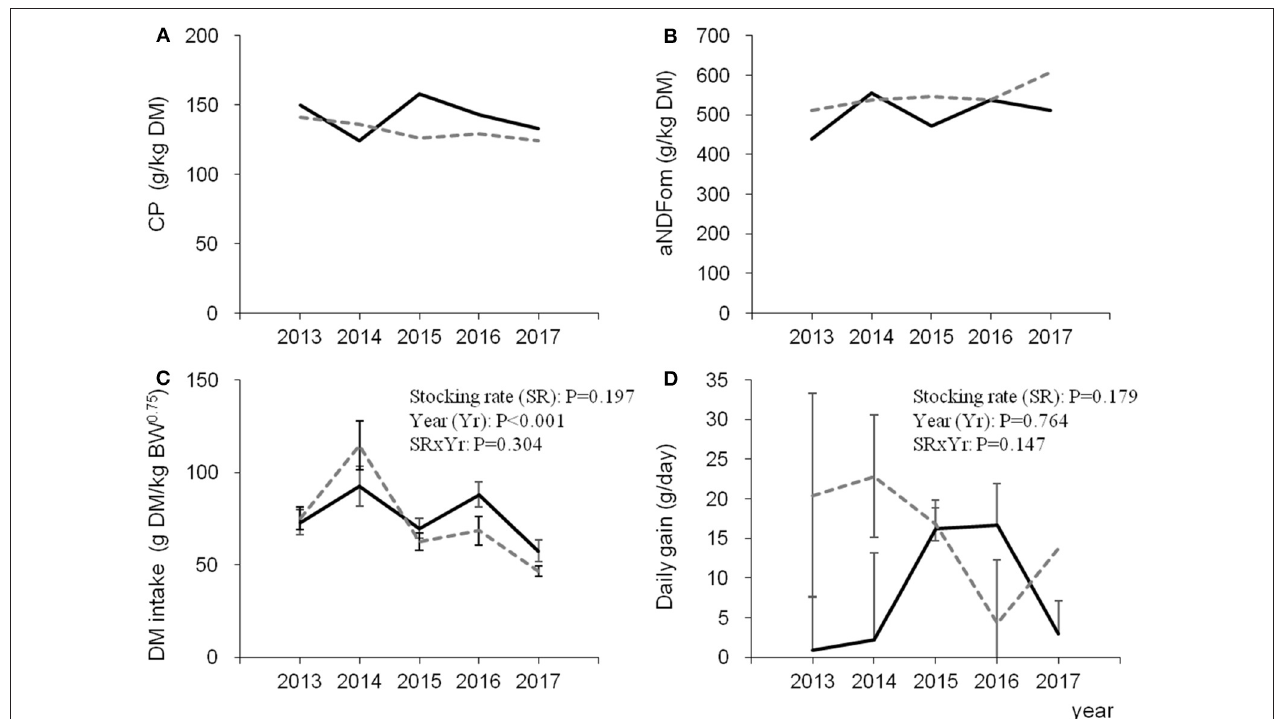
FIGURE 1 | Crude protein (CP: A ) and neutral detergent fiber (aNDFom: B ) contents in ingested forage, and dry matter (DM) intake (C) and daily gain (D) of grazing goats in high stocking rate (—) and low stocking rate (– – –) during five-year grazing at an abandoned field.